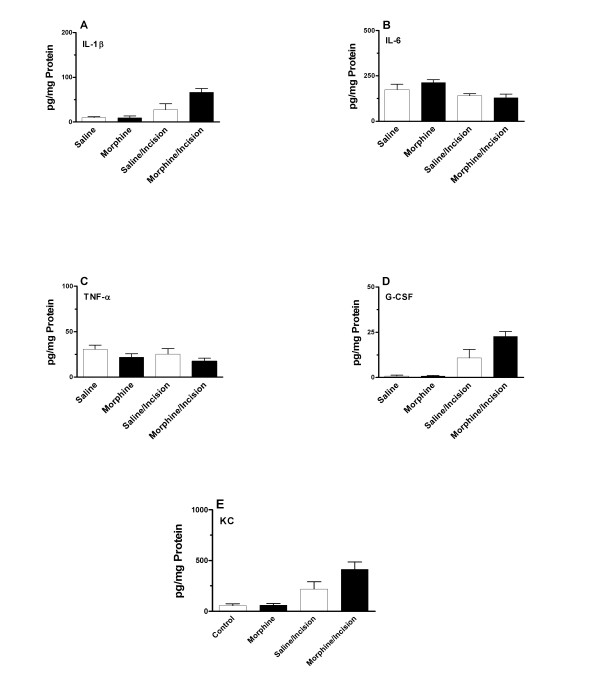
Peri-incisional skin cytokine levels for mice treated with saline or morphine beginning at the time of incision. The figure displays cytokine measurements from mice in four different treatment groups: saline, incision/saline, no incision/morphine, incision/morphine. The cytokine levels were assessed at 120 hours after the incisions were made (18 hours after the last dose of morphine). Statistical analysis was performed to detect differences between each set of conditions. N = 8/group.